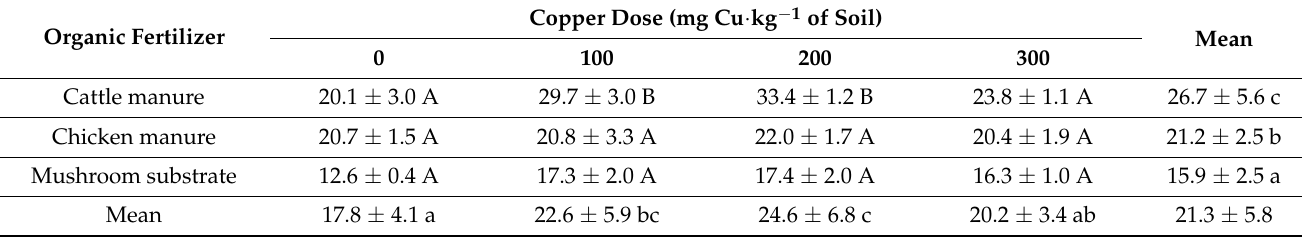
Table 7. Total utilization of nitrogen from organic fertilizers by cocksfoot in three years times, % (mean ± SD). Organic